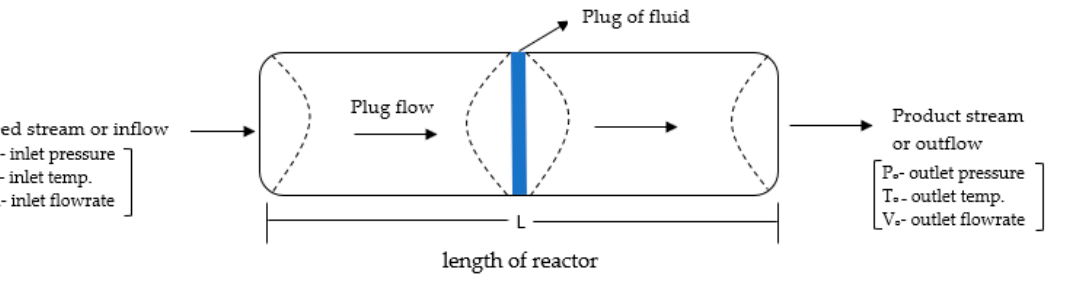
Figure 7. Plug flow reactor [27].